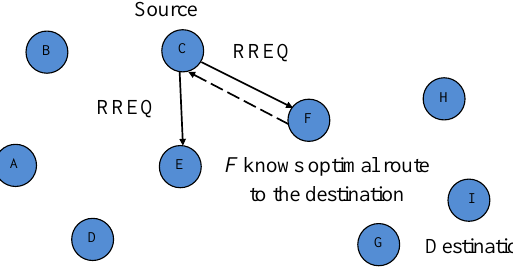
Figure 7. Network scenario where the neighboring node knows the optimal route to the destination.